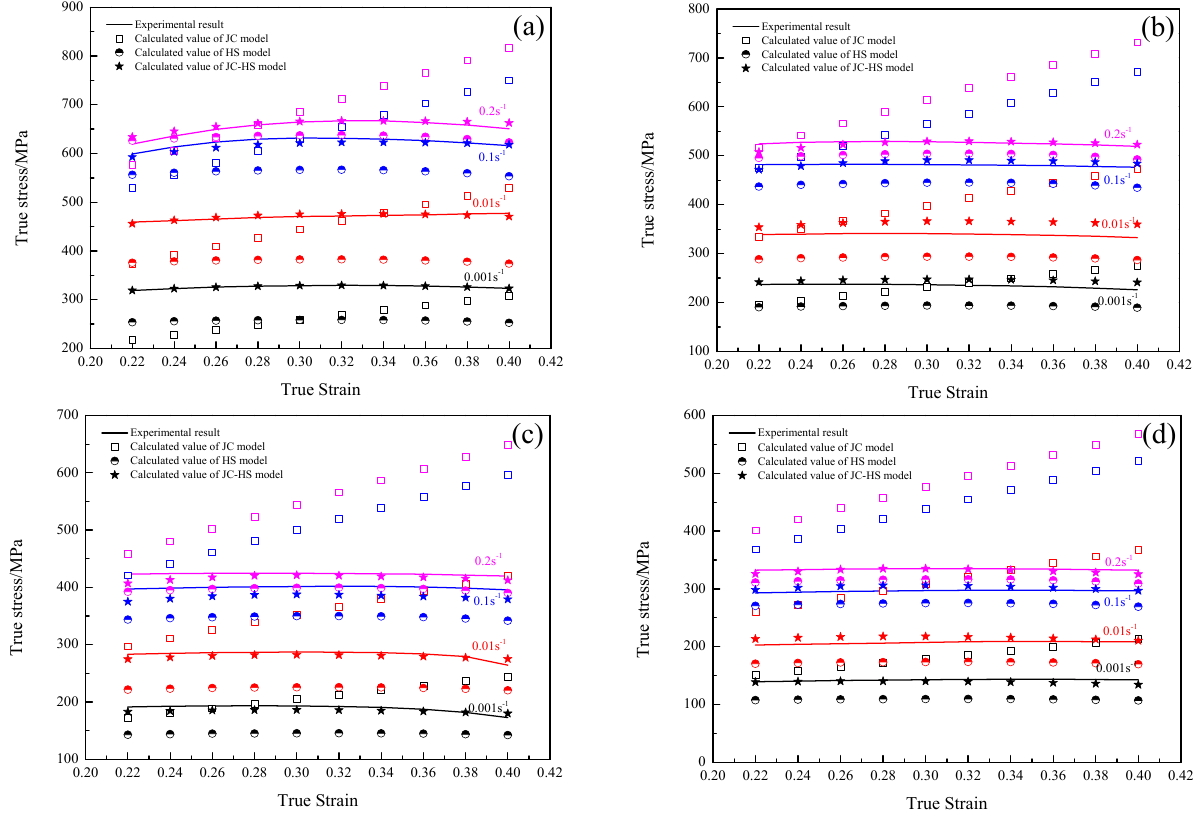
Figure 15. The experimental true stress and calculated by the JC model, HS model and JC-HS model of GH3230 superalloy double-sheet at different deformation temperatures: ( a ) 1123 K; ( b ) 1173 K; ( c ) 1223 K; ( d ) 1273 K.